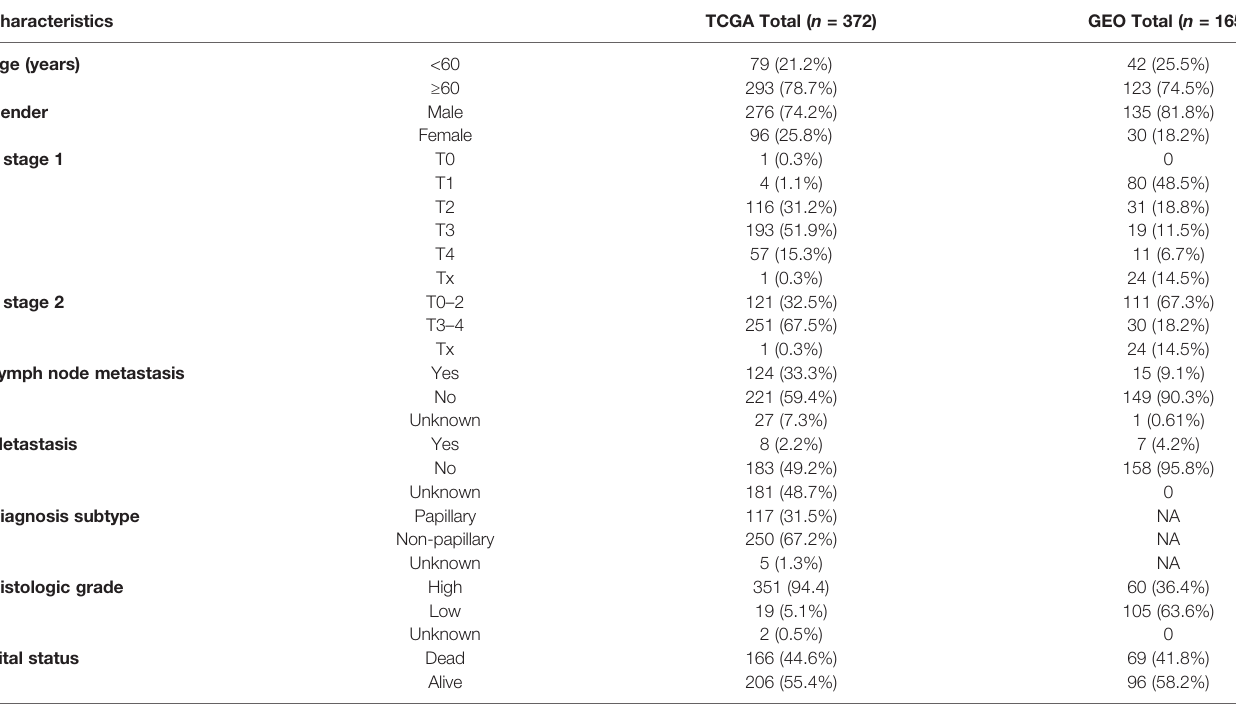
TABLE 1 | Clinical characteristics of BLCA patients in the TCGA cohort and GEO GSE13507.